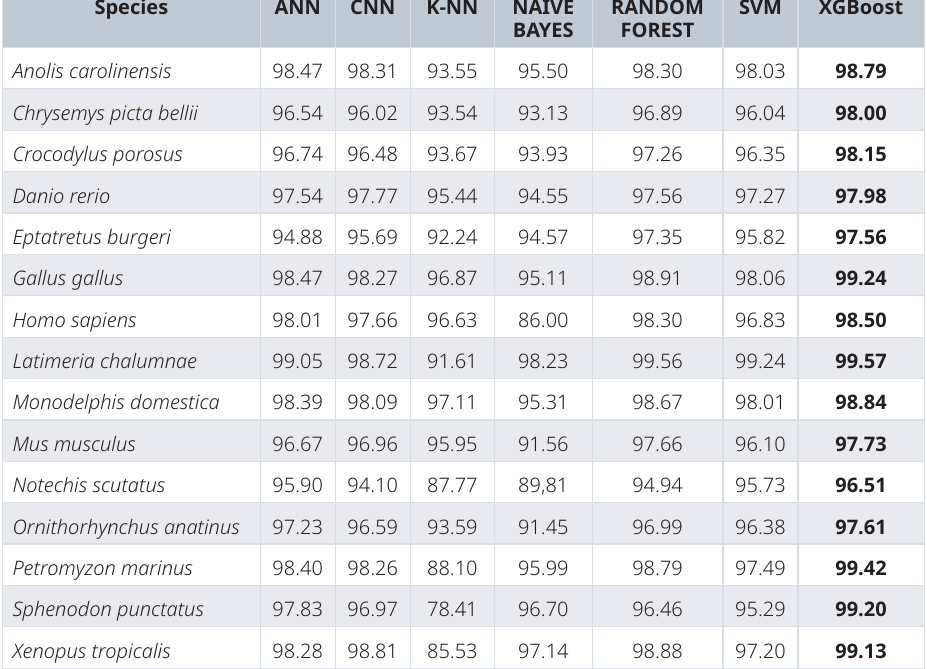
Table 2. Benchmarking machine learning methods for coding potential prediction based on trinucleotides count. F1-score for each one of the 15 species in which the algorithms were tested. Other metrics (sensitivity, specificity, precision, accuracy and the confusion matrix) used for the comparison of the algorithm’s performance were made available at the Extended data: Supplementary File S2 19